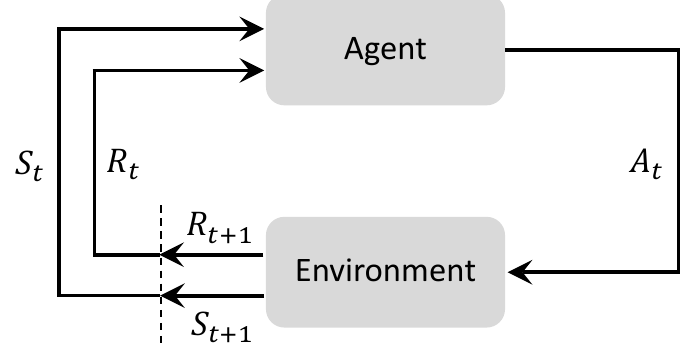
Figure 1: The q-learning concept where an agent chooses an action A t , based on the current state S t , which affects the environment. This action is then given a reward R t +1 and leads to state S t +1 . Eq. (5) is used to incorporate this reward into the saved reward for the current state R t , and the cycle starts